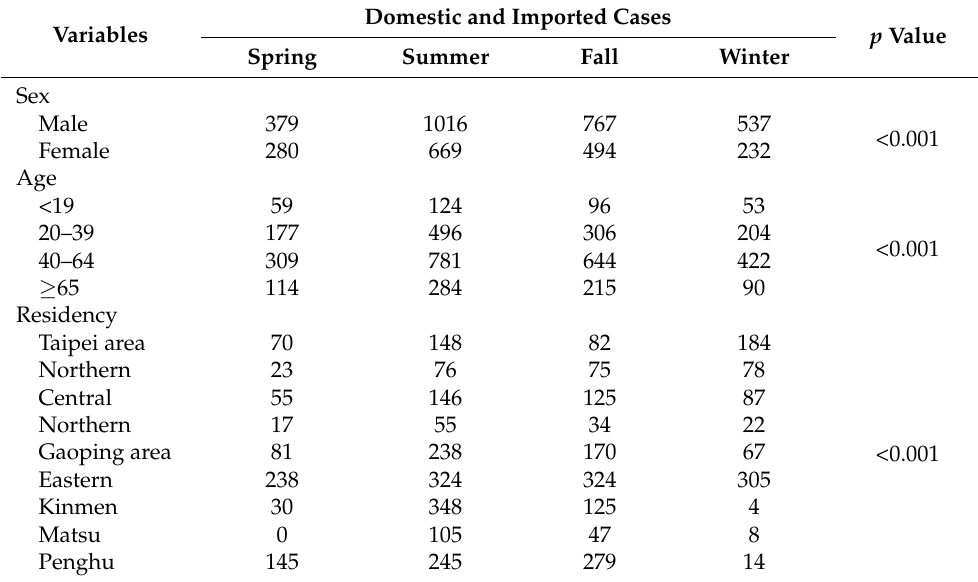
Table 3. Association between season and gender, age and region of residence from a survey of domestic and imported cases of scrub typhus between 2010 and 2019 in Taiwan.